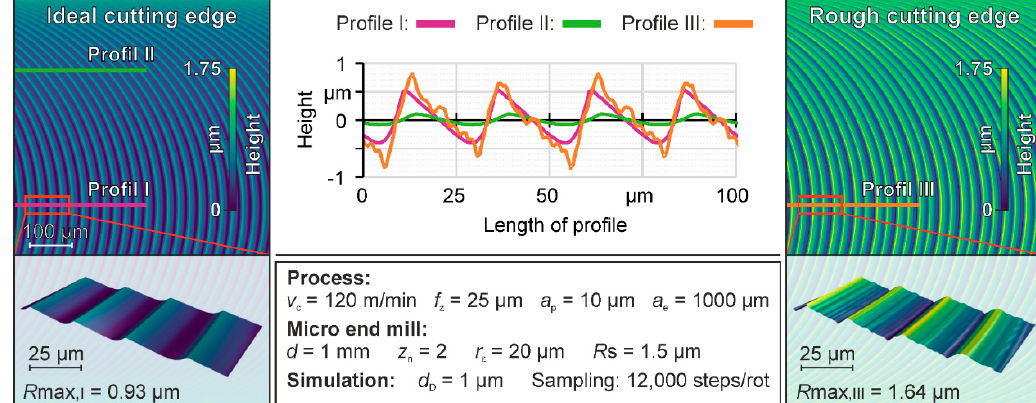
Figure 13. Influence of the microgeometric properties of cutting edges on the surface roughness, comparing an ideal shape ( left ) with a detailed representation ( right ).